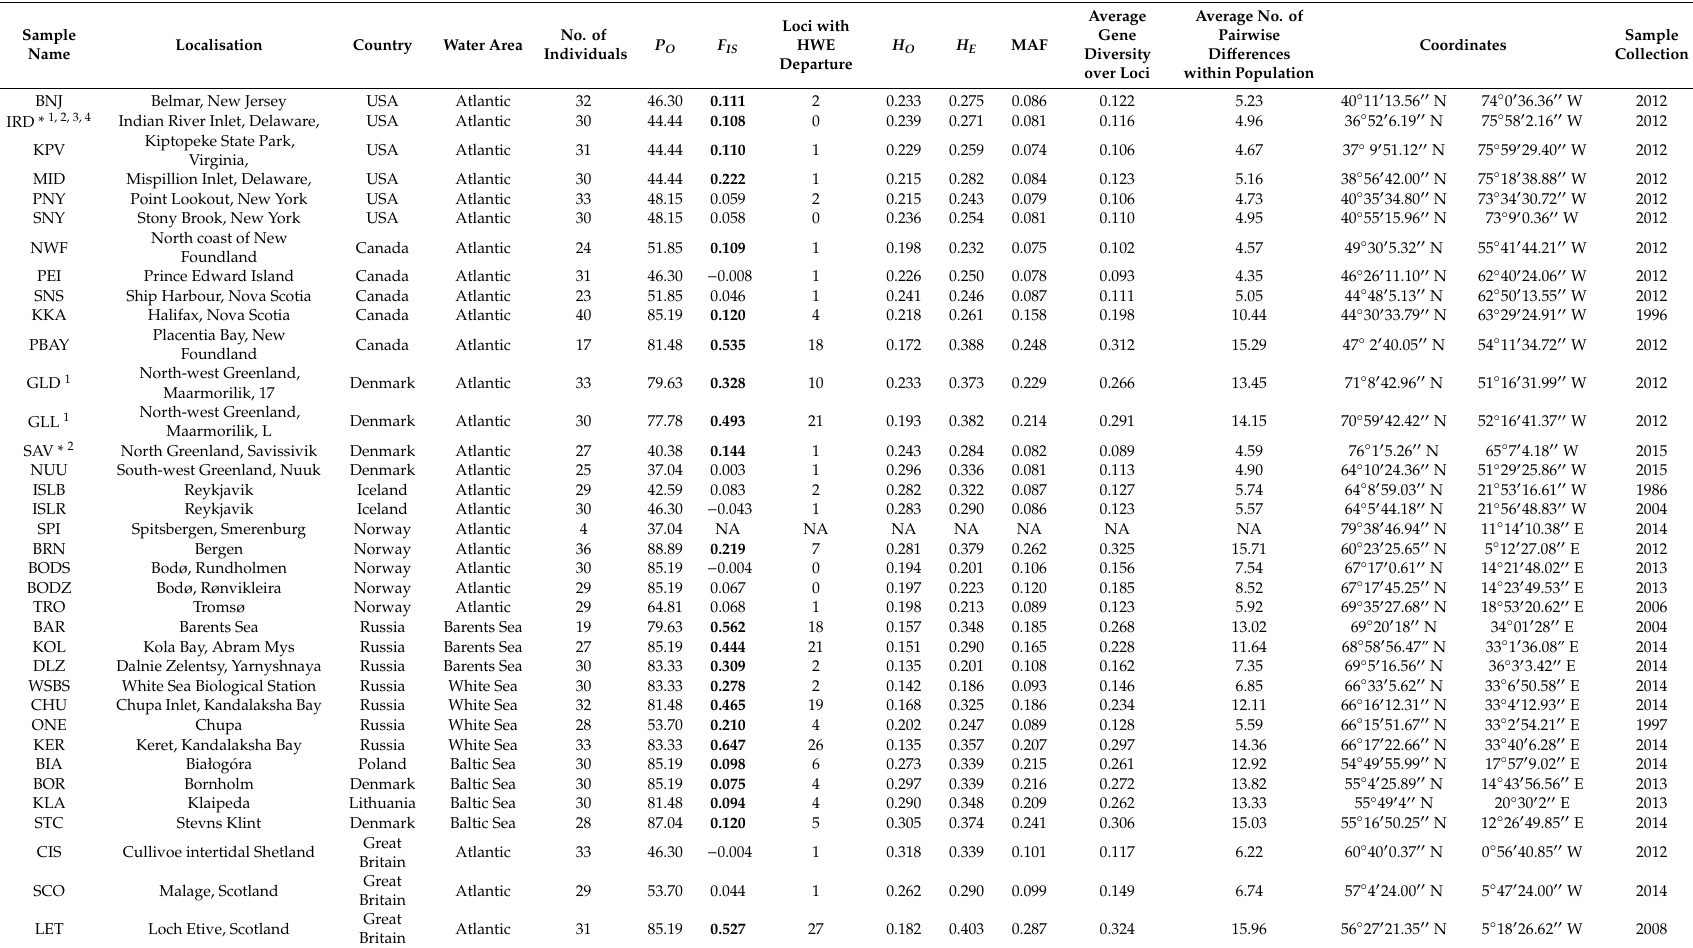
Table 1. Genetic parameters of the 53 Mytilus mussel samples, including proportion of polymorphic loci, FIS values, loci not in HWE, observed and expected heterozygosity, minor allele frequency, average gene diversity per locus and average number of pairwise di ff erences within